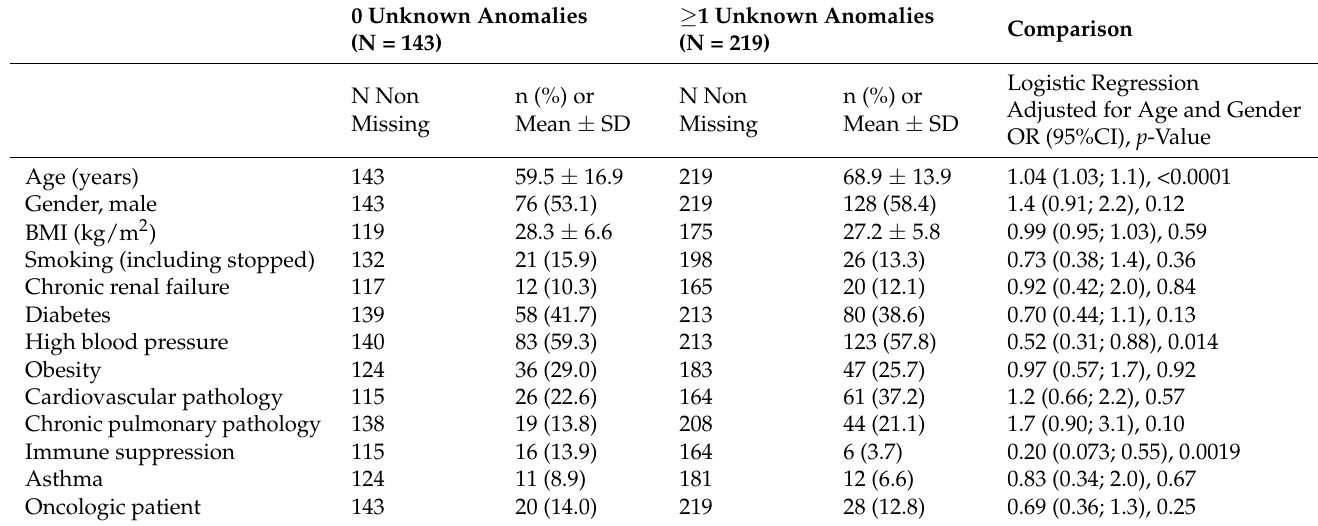
Table A2. Patients’ description in function of the presence of unknown anomalies on CT scan (N = 362).